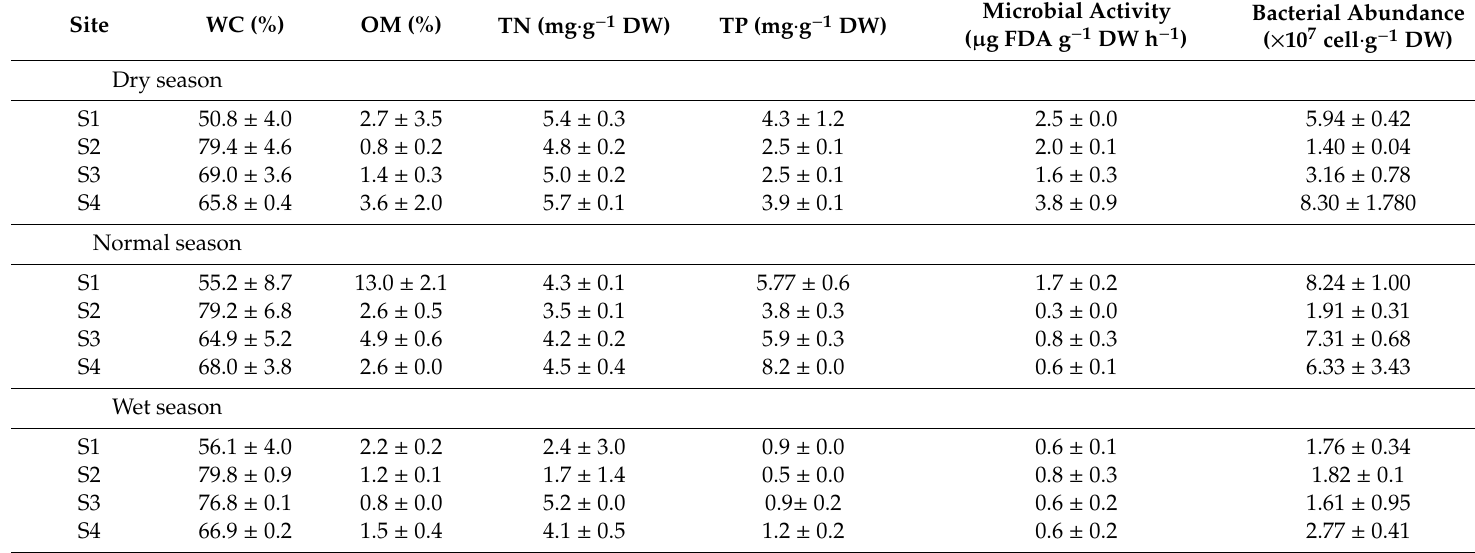
Table 2. Physical and chemical characteristics (mean ± standard deviation) in sediment upstream and downstream of Gongguoqiao hydroelectric